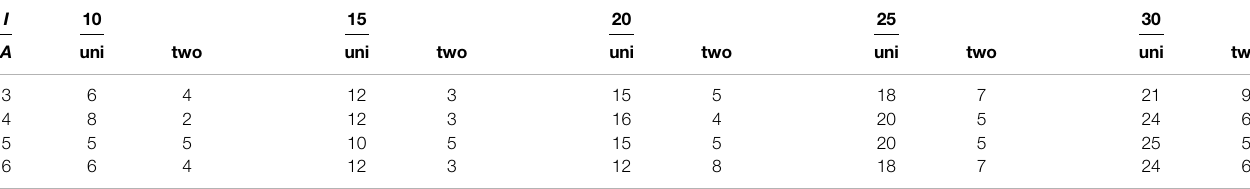
TABLE 2 | Number of unidimensional (uni) and two-dimensional (two) items per condition resulting from crossing the number of attributes and items.